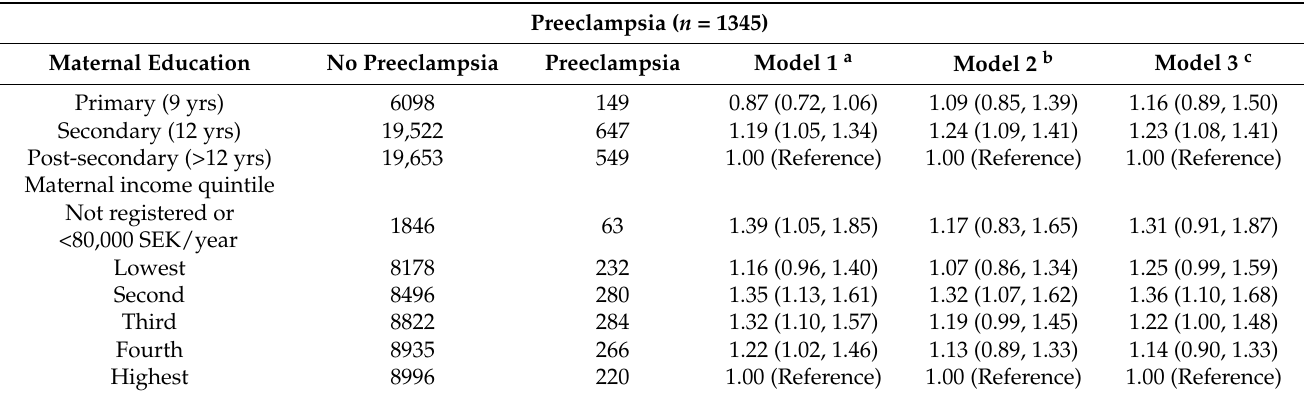
Table 2. Risk ratios (RR) and 95% confidence intervals (CI) for gestational diabetes and preeclampsia by maternal education and income level.